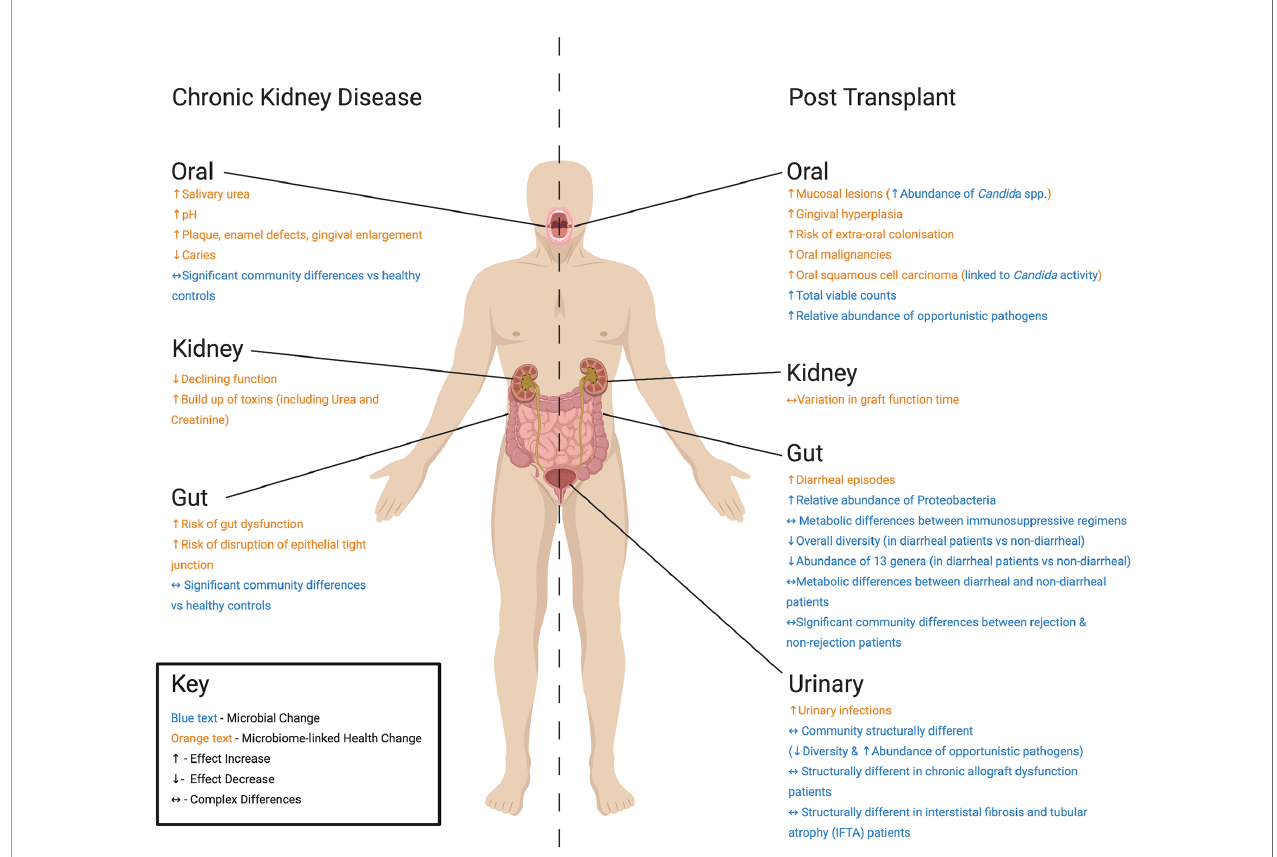
FIGURE 1 | Summary of differences found at key body sites in studies of Chronic Kidney Disease (CKD) patients and kidney transplant recipients post-operation discussed in this review. For CKD patients, health changes associated with microbiome alteration include: (Oral) increased urea and pH (Lasisi et al., 2016), plaque, enamel defects, gingival enlargement and decreased caries (Al Nowaiser et al., 2003), (Kidney) declining function and build-up of toxins (Pandya et al., 2016), and (Gut) gut dysfunction and disruption of epithelial tight junction (Vaziri et al., 2013b). Reported microbial change includes signi fi cant changes in oral and gut communities compared with healthy controls (Hu et al., 2018; Hobby et al., 2019). For kidney transplant recipients, post-transplant health changes associated with microbiome alteration include: (Oral) increased mucosal lesions, gingival hyperplasia, risk of extra-oral colonization, and squamous cell carcinoma (Spolidorio et al., 2006), (Kidney) variations in time taken for graft to function (Yarlagadda et al., 2009; Willicombe et al., 2017), (Gut) increased diarrheal episodes (Lee et al., 2014), and (Urinary Tract) increases in urinary tract infections (Giessing, 2012). Microbial changes include: (Oral) increased abundance of Candida species (Spolidorio et al., 2006), total viable microorganism counts (Saraiva et al., 2006), and relative abundance of opportunistic pathogens (Diaz et al., 2013), (Gut) increased relative abundance of Proteobacteria (Lee et al., 2014), changes in microbial metabolism between (i) immunosuppressive regimens (Zaza et al., 2017), as well as microbial community structure in (ii) rejection and non-rejection patients (Lee et al., 2014) and (iii) diarrheal and non-diarrheal patients (Lee et al., 2019). (Urinary Tract) Structurally different microbiomes are also seen in transplant recipients (Fricke et al., 2014), as well as chronic allograft dysfunction (Wu et al., 2018) and interstistal fi brosis and tubular atrophy patients (Modena et al.,